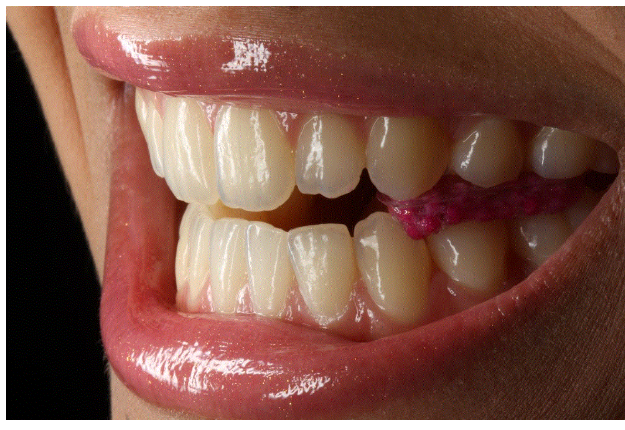
Fig.2. Completely toothed patient chewing the